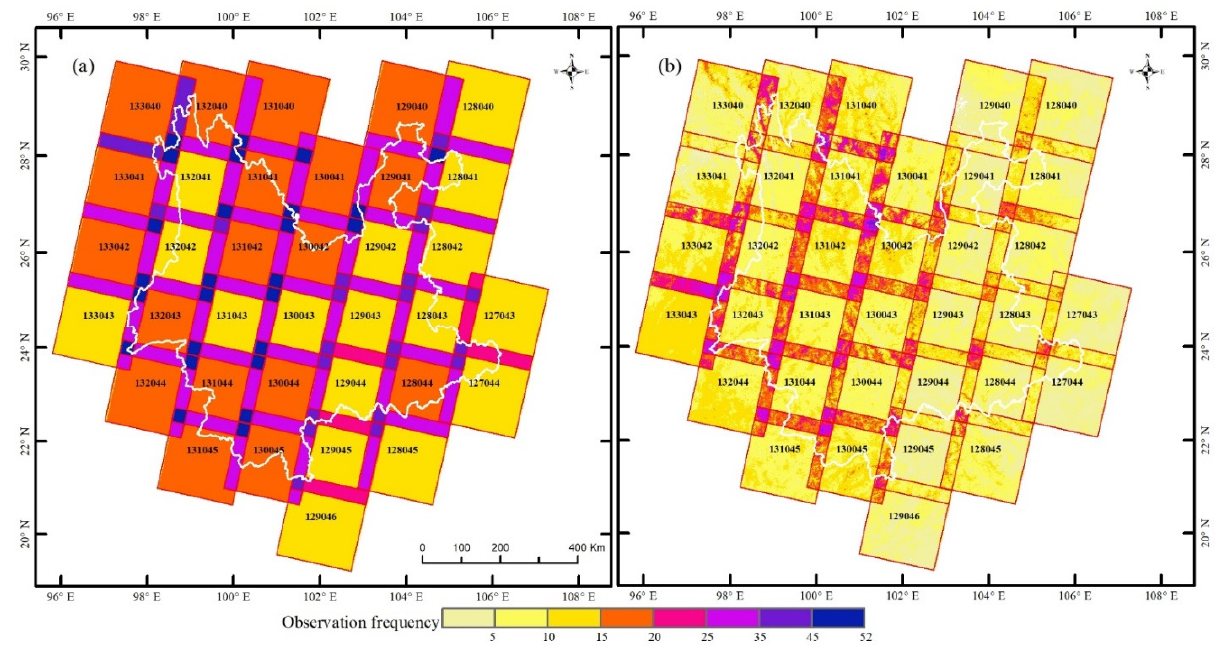
Figure 8. The observation frequency of 35 scenes of Landsat 8 images over the whole region. ( a ) initial observation frequency; ( b ) observation frequency after the elimination of cloud-affected pixels.